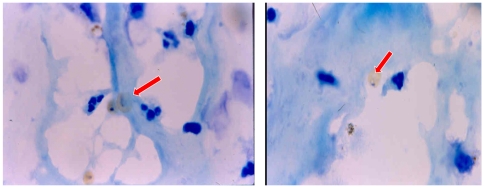

P.vivax infected red blood cells (arrows) adherent to the surface of fresh placenta.